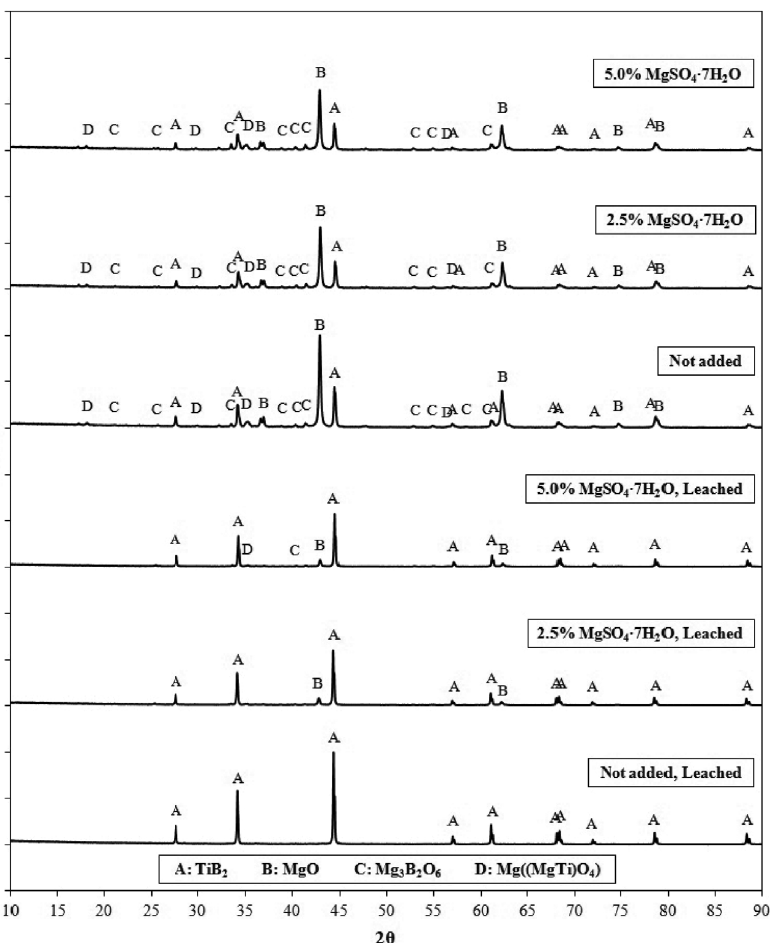
Fig. 5: XRD patterns of unleached and leached SHS products synthesized under argon atmosphere and stoichiometrically 100% Mg addition with increasing MgSO 4 ·7H 2 O addition ratio